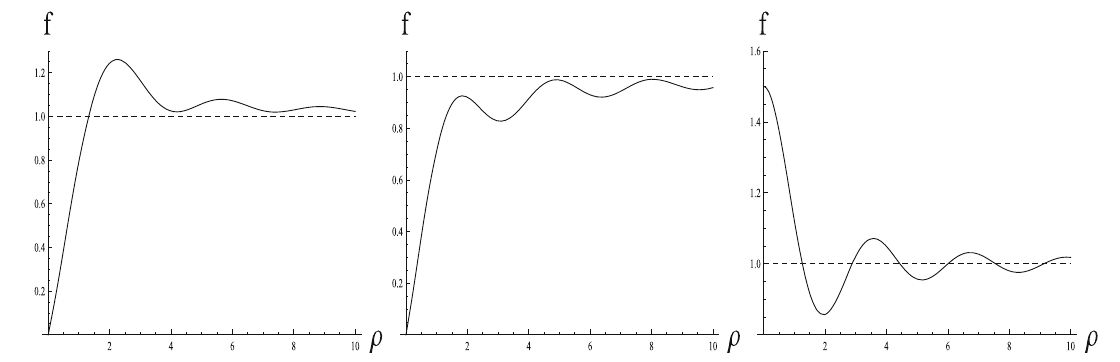
Fig. 1 f as a function of ρ for α = ( 1 , 0 , 0 ),( 0 , 1 , 0 ),( 0 , 0 , 1 ) respectively. Here ρ is in the unit of 1 /ω